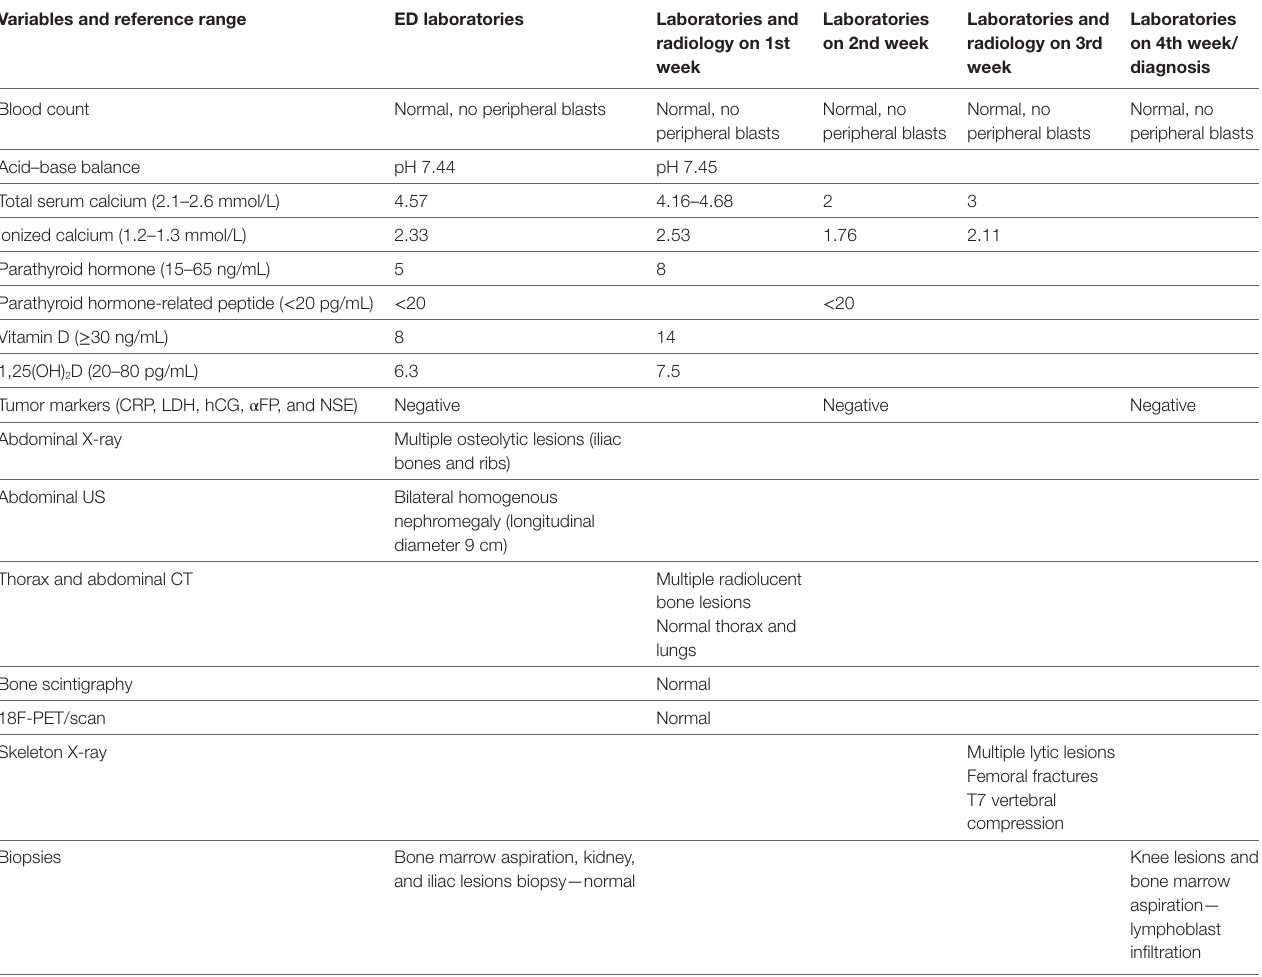
table 1 | From admission to diagnosis—biochemical, radiological, and histological evolution. Variables and reference range